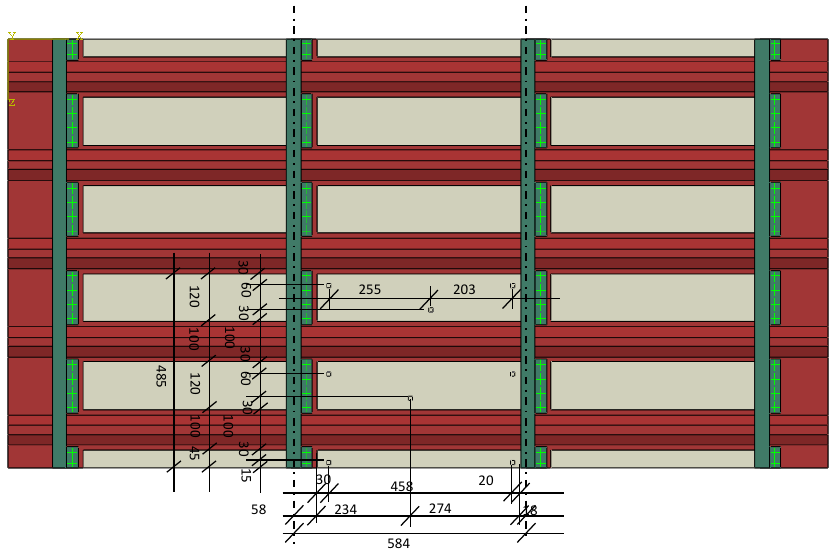
Figure 5. Sensor locations for the section of the panel. The quotes are expressed in millimiters.